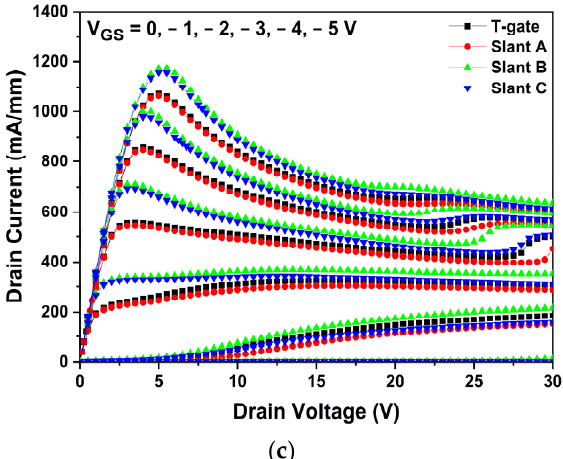
Figure 7. Simulated results of the DC characteristics of the slant-gate structures: I DS -V GS transfer characteristics at ( a ) V DS = 10 V and ( b ) V DS = 20 V; and ( c ) drain current–drain voltage (I DS -V DS ) output characteristics at gate voltages of − 5, − 4, − 3, − 2, − 1, and 0 V.